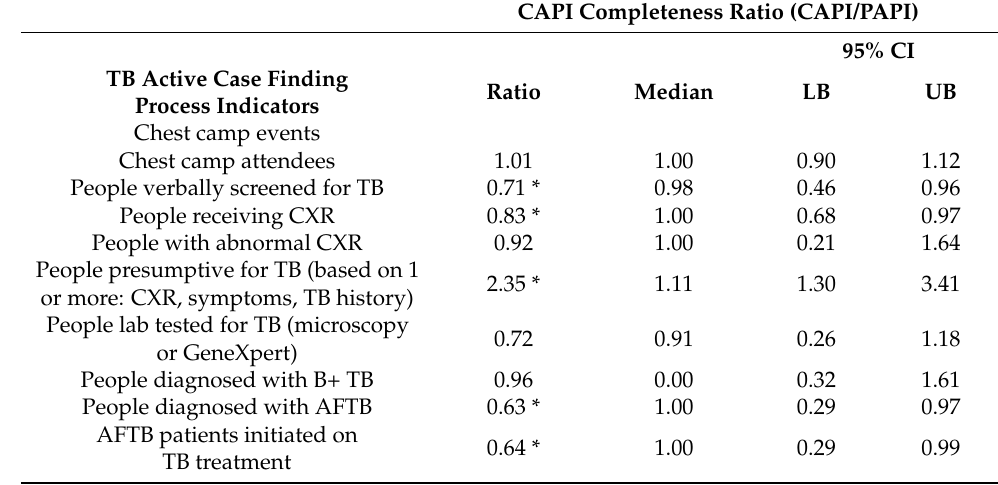
Table 2. Completeness of CAPI records per TB active case finding process indicator.